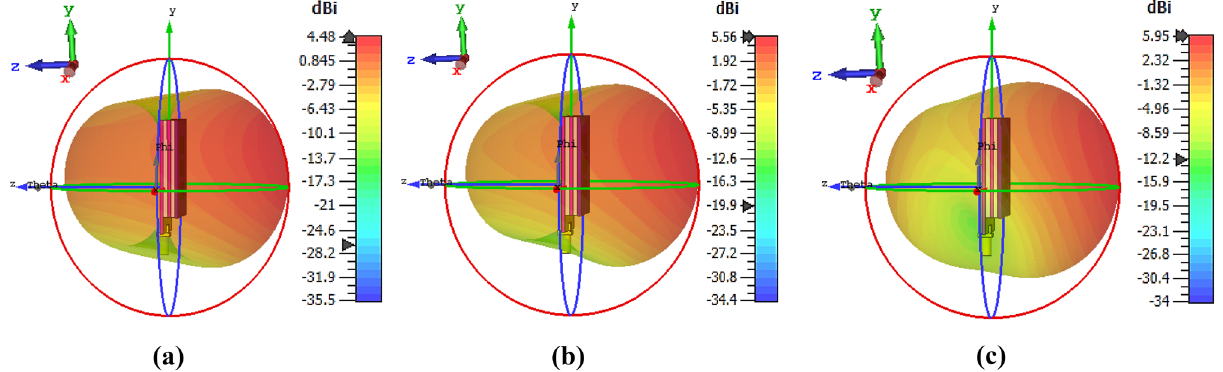
Figure 10. 3D radiation pattern of the proposed antenna at: ( a ) 2.24 GHz; ( b ) 2.66 GHz; ( c ) 2.84